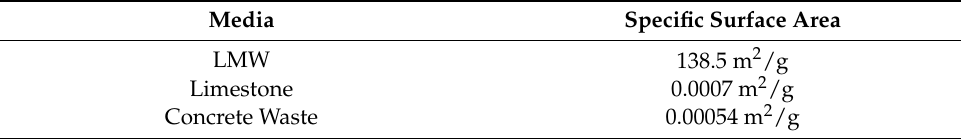
Table 6. Specific surface area of each